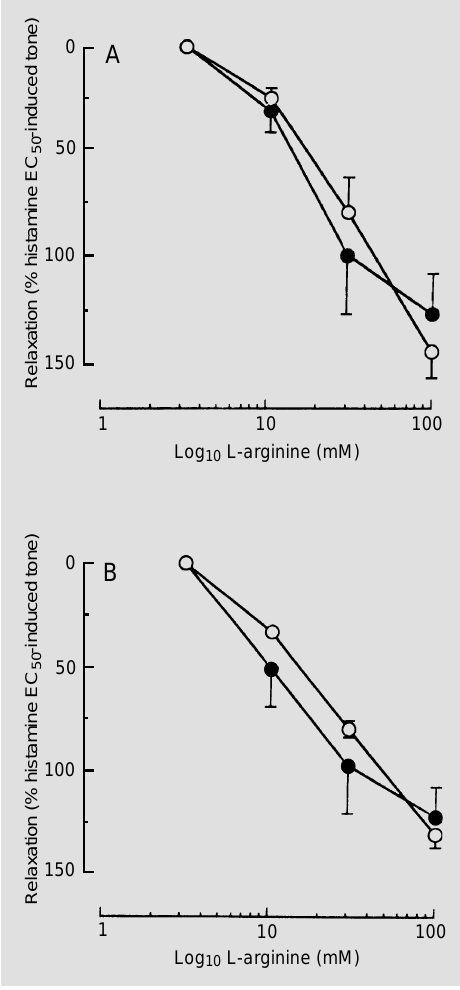
Figure 4 - Relaxation concentra- tion-effect curves for L-arginine in absence (A) and presence (B) of L-NAME (50 mM) in epithe- lium-intact (open circles) and epi- thelium-denuded (closed circles) guinea-pig isolated trachea pre- contracted with histamine (EC 50 ). Each point represents the mean of 5-6 observations and vertical bars represent the SEM. Indomethacin (5 µM) is present